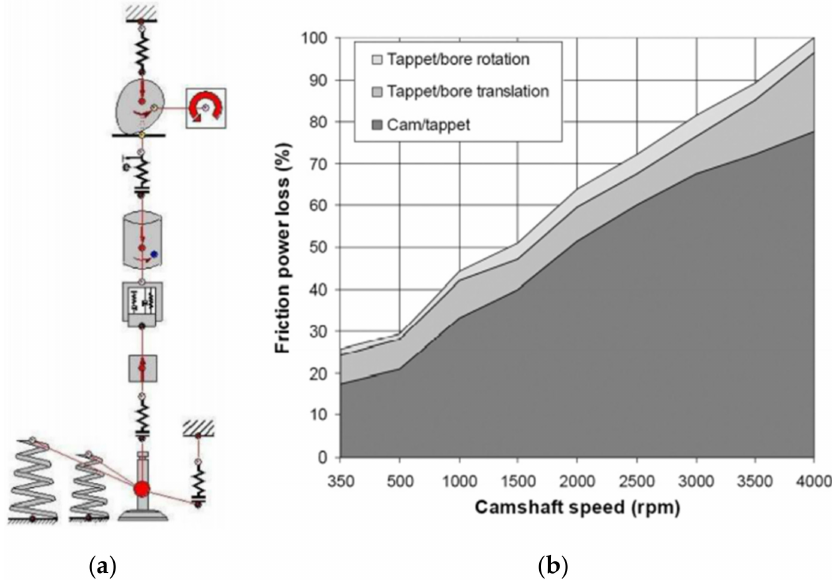
Figure 7. Numerical modelling of a valvetrain system to quantify the frictions in [51]. ( a ) Valvetrain model, ( b ) Predicted friction power loss by valvetrain contacts versus camshaft speeds.